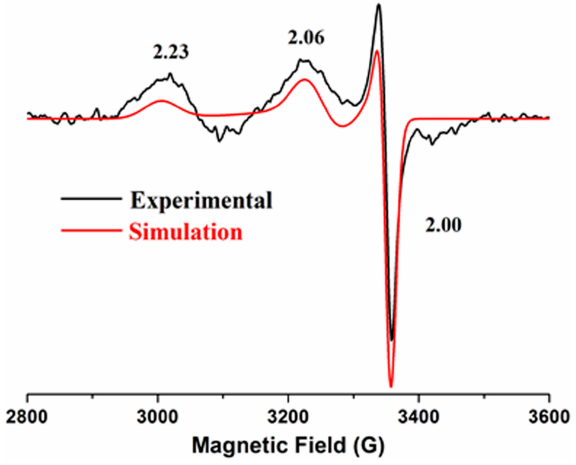
Figure 4. X-band EPR spectrum of EFG-F598H as a representative at 2 K in the presence of ~1 equiv of KO 2 (microwave frequency, 9.49 GHz; microwave power, 20 mW; modulation amplitude, 5 G). The red line was obtained by simulation.